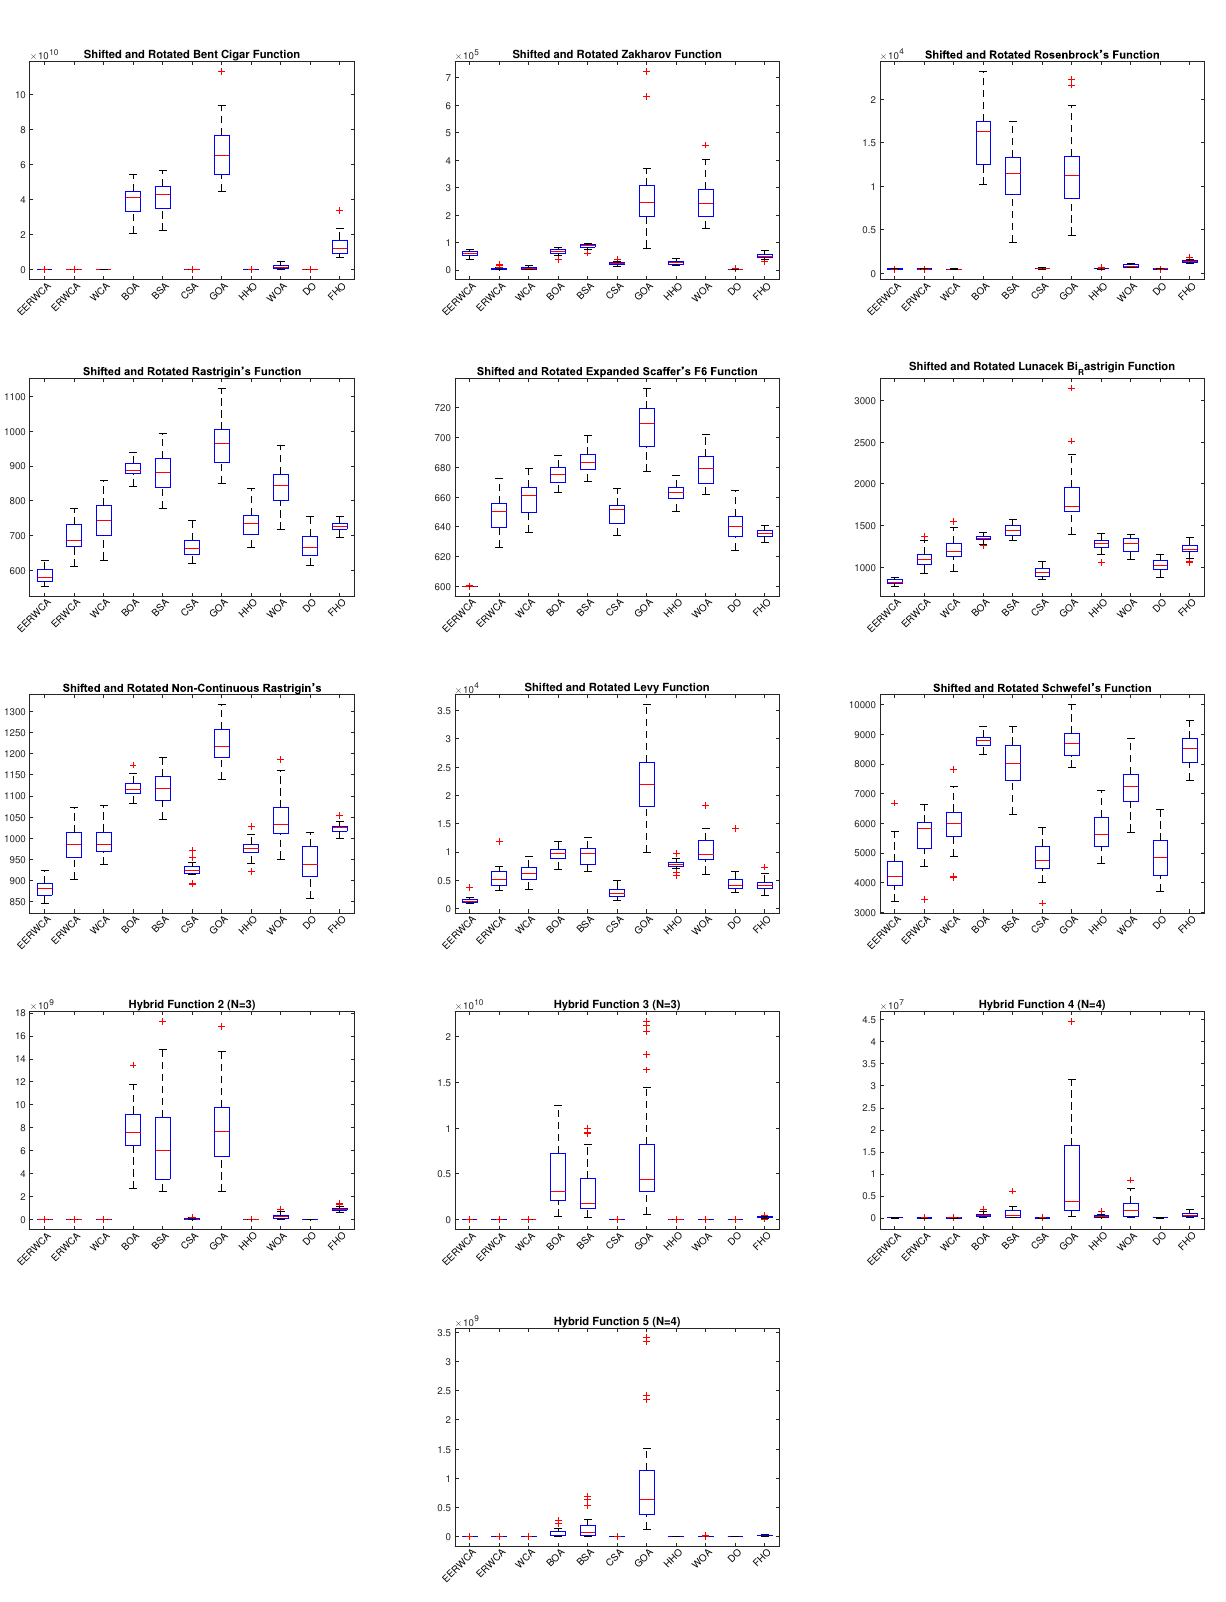
Figure 4. Box plots of some functions from F1–F15 for all algorithms using CEC2017 and dim =